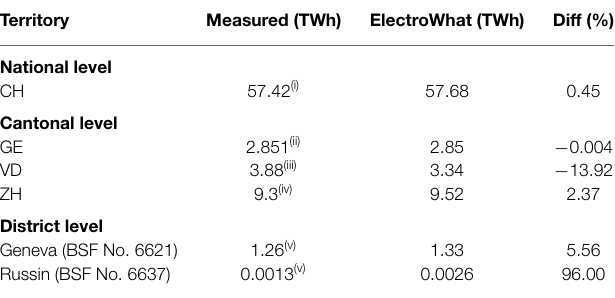
TABLE 3 | Comparison of aggregated yearly demand estimations with other data sources. Territory